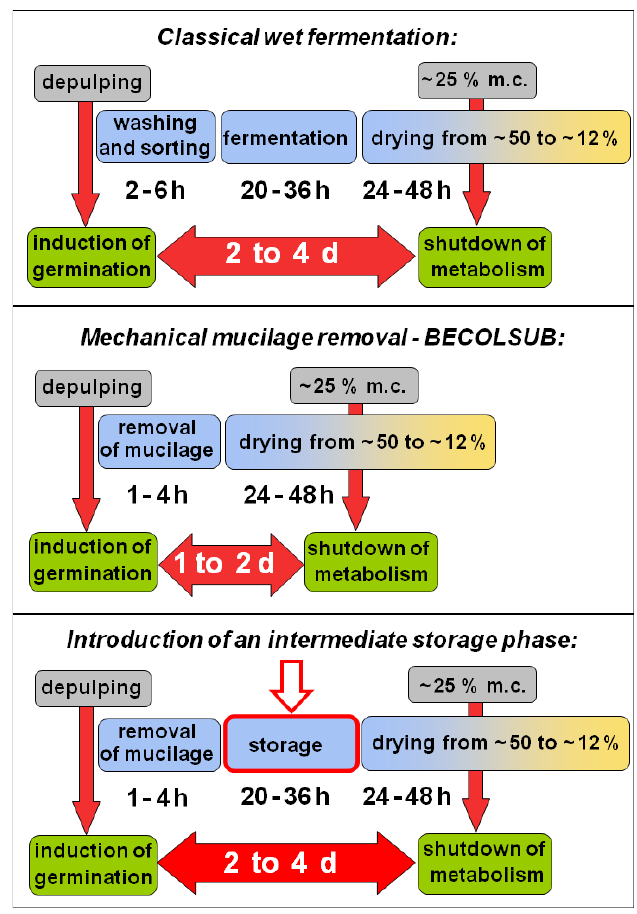
Fig. 1: Introduction of an intermediate storage phase in the BECOLSUB green coffee